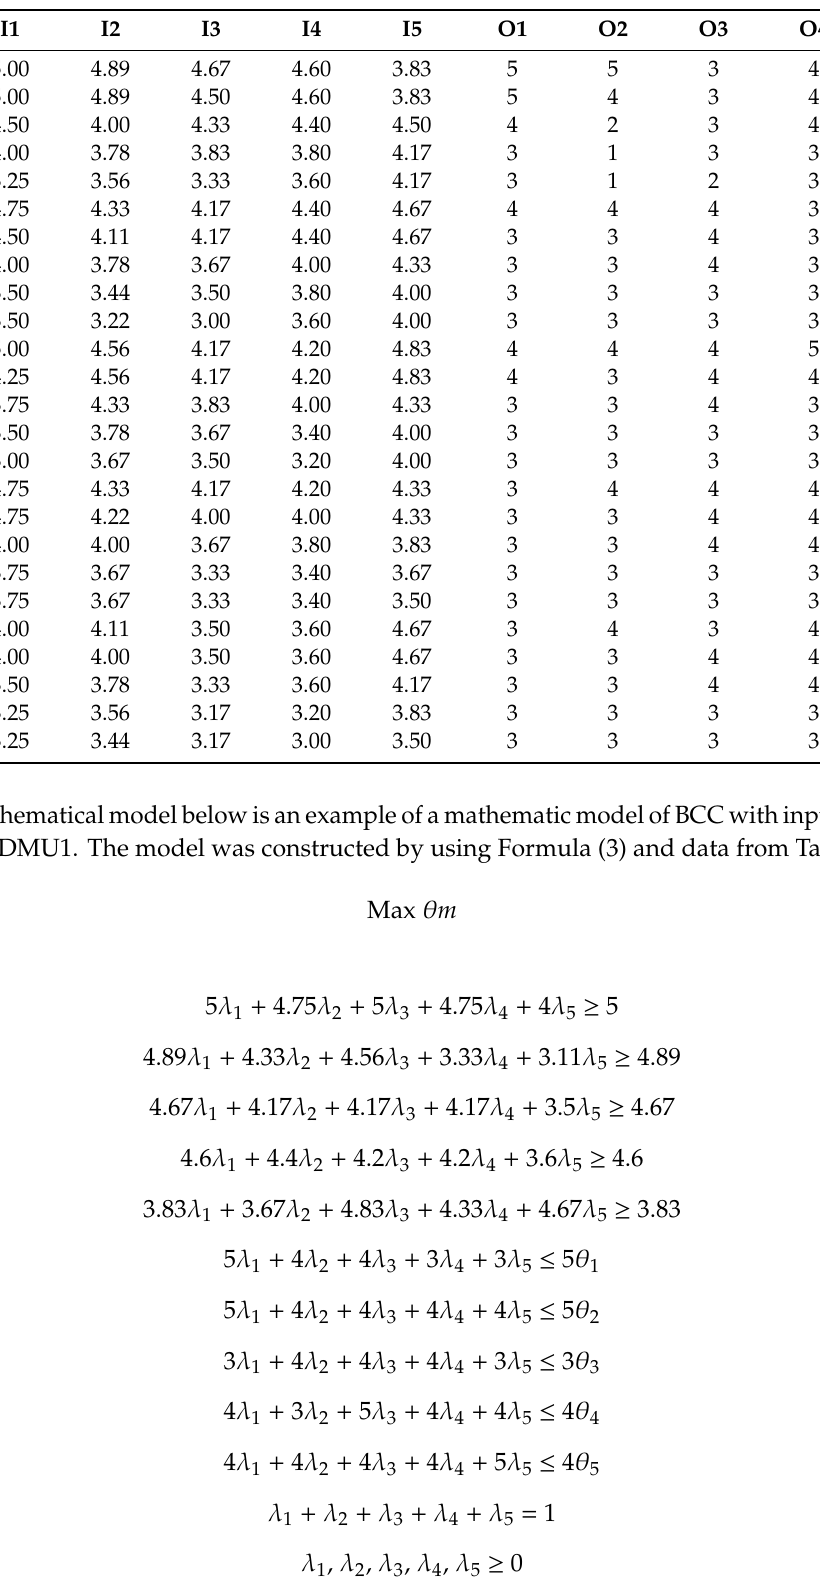
Table 6. Strategy assessment data for respective